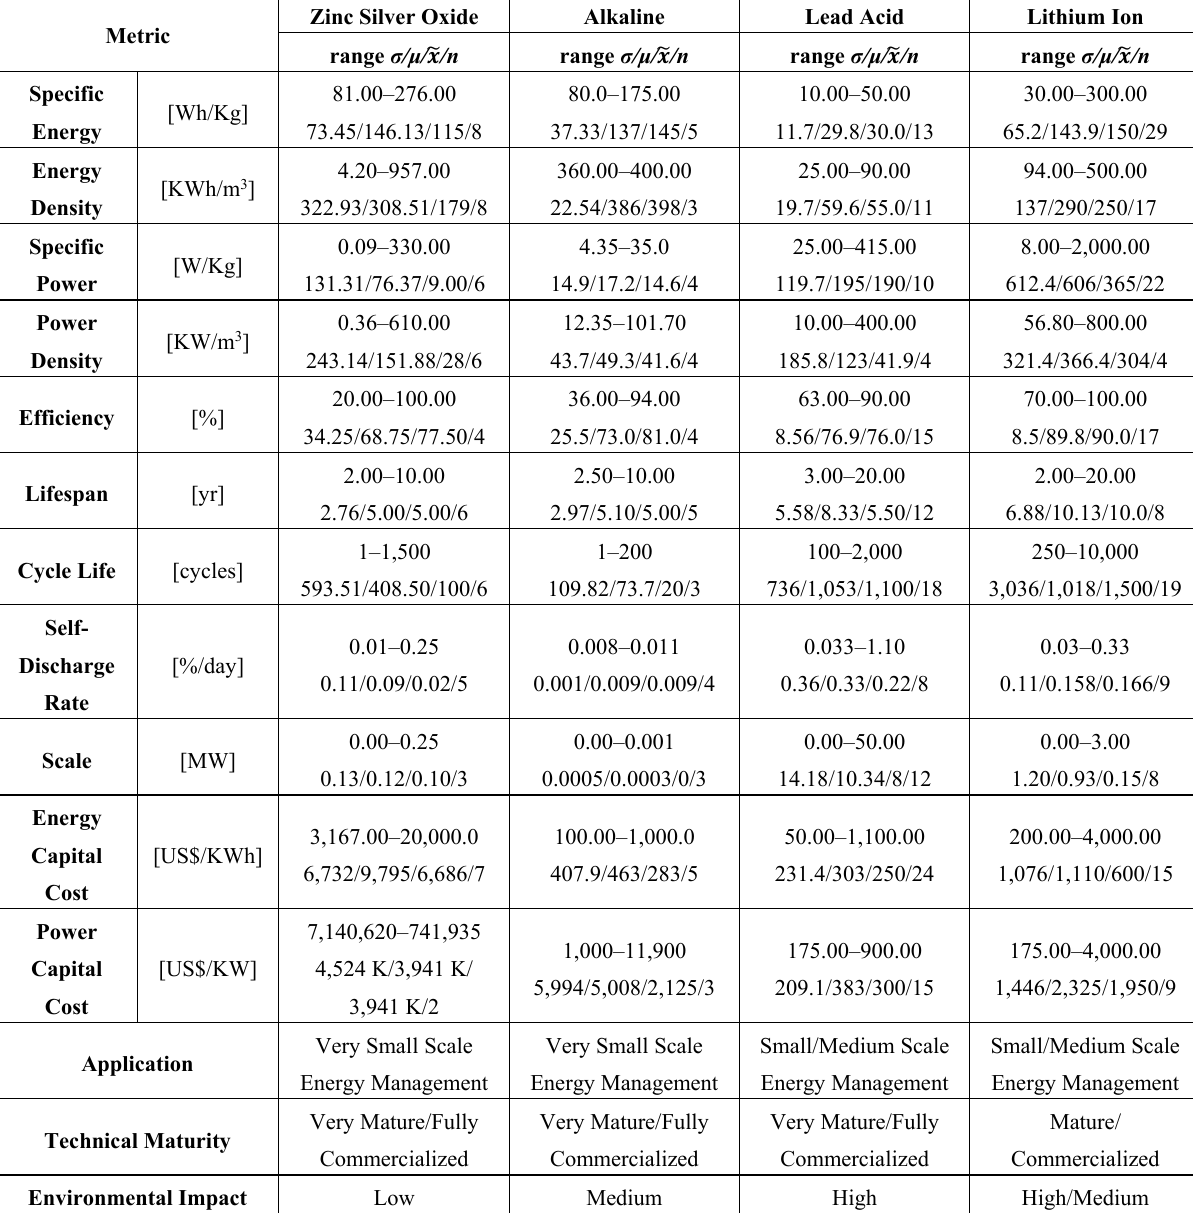
Table 4. Comparing typical chemical batteries based on fourteen different metrics. Data obtained or calculated from multiple sources